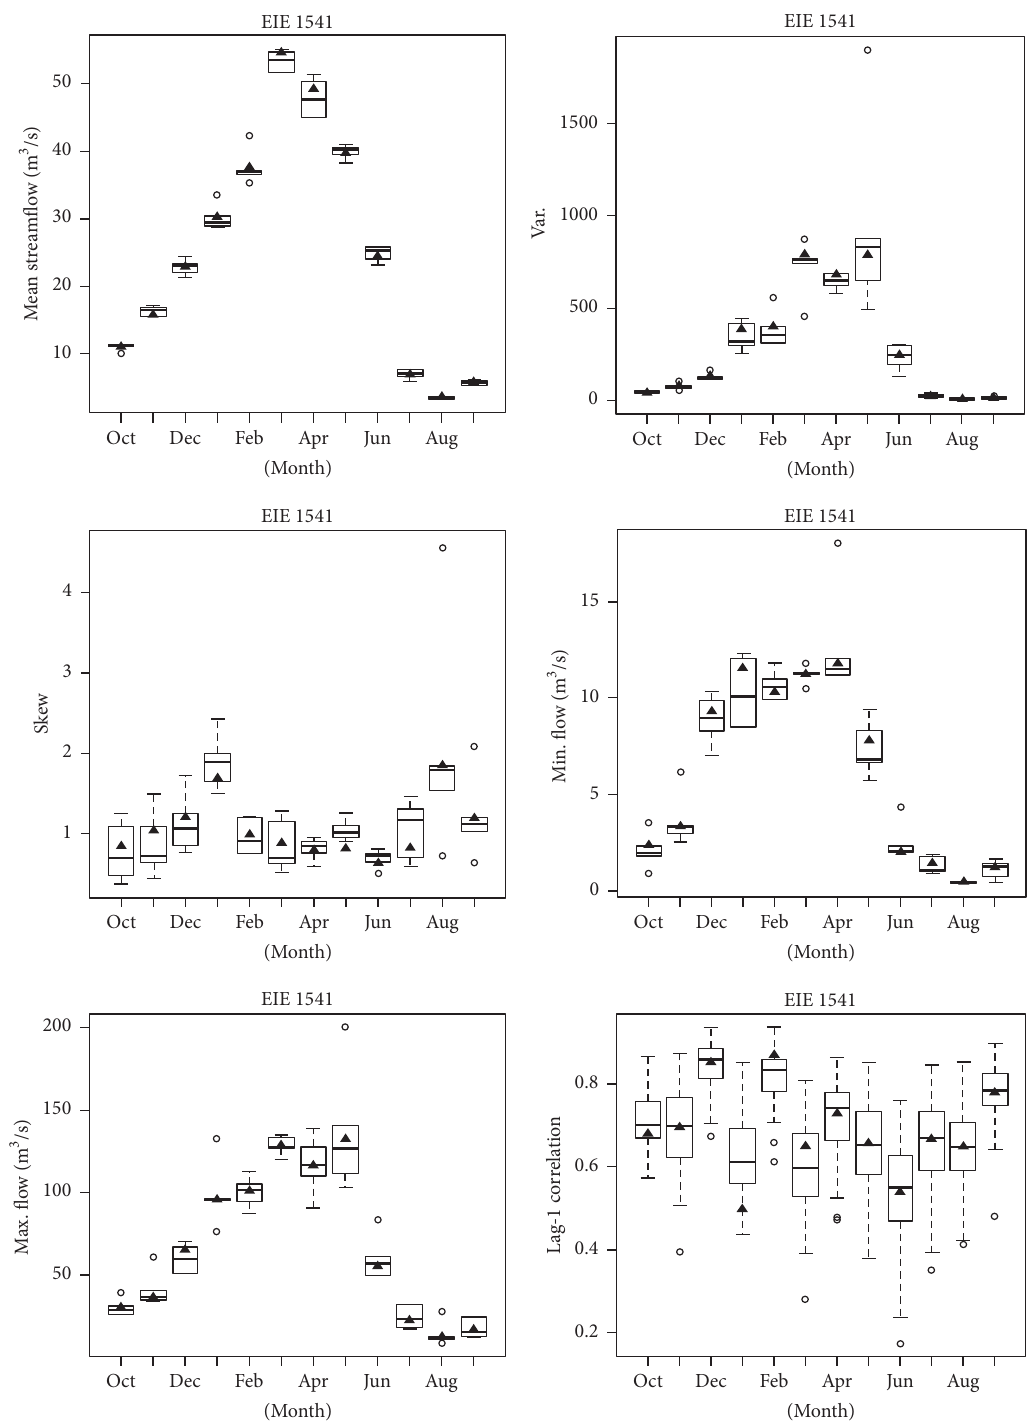
Figure 4: Simulated and observed statistics values from EIE1541 station. The triangle denotes the observed